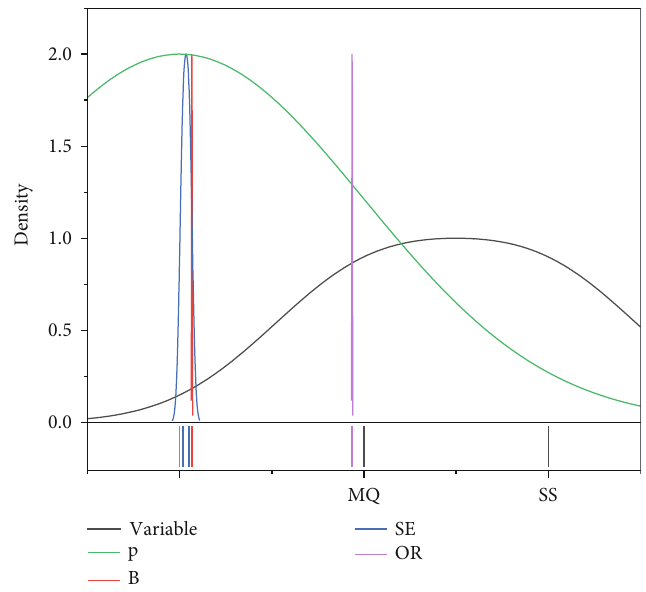
Figure 3: Binary logistic regression analysis of MQ and SS as predictor